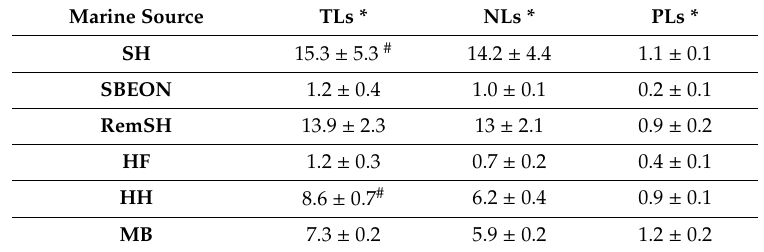
Table 1. Lipid content (TLs, PLs, and NLs) of SH, SBEON, RemSH, HH, HF, and MB.